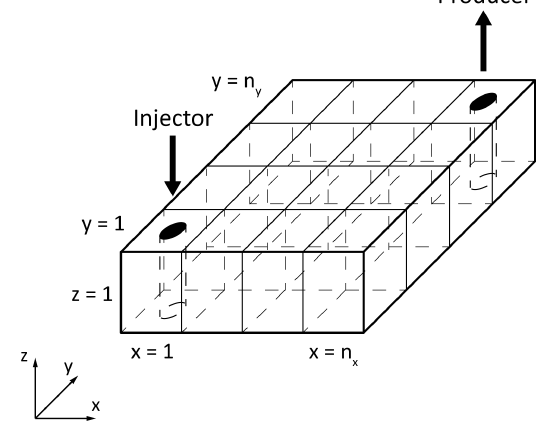
Figure 2. Schematic representation of the quarter 5-spot used for the EOR simulations (Reproduced with permission from Druetta [28], Elsevier,